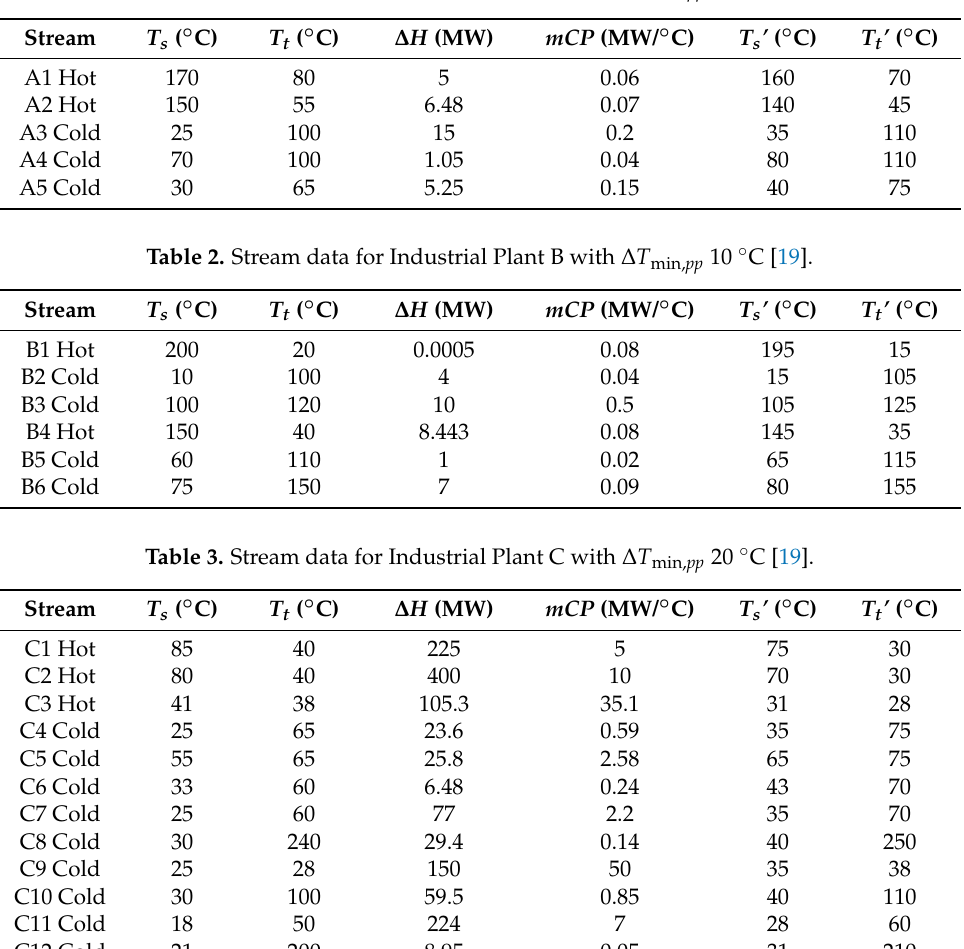
Table 1. Stream data for Industrial Plant A with ∆ T min, pp 20 ◦ C [19].